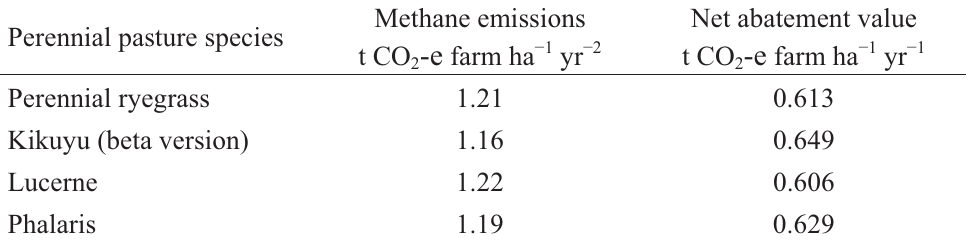
Table 4. Sensitivity analysis of methane emissions and net greenhouse gas (GHG) (cid:3) emissions abatement value with the inclusion of alternative perennial pasture species in the GrassGro simulation